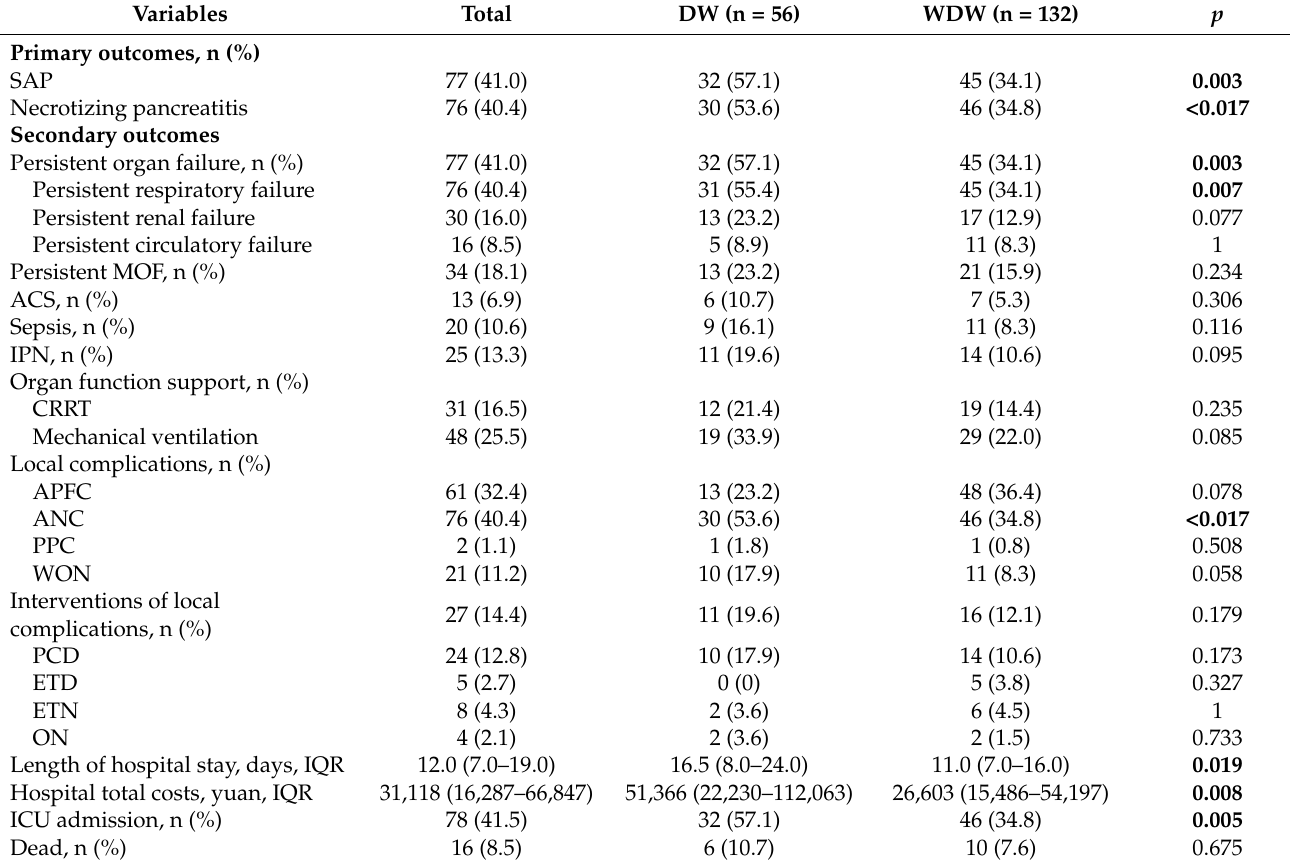
Table 5. Comparison of clinical outcomes in patients in DW group and WDW